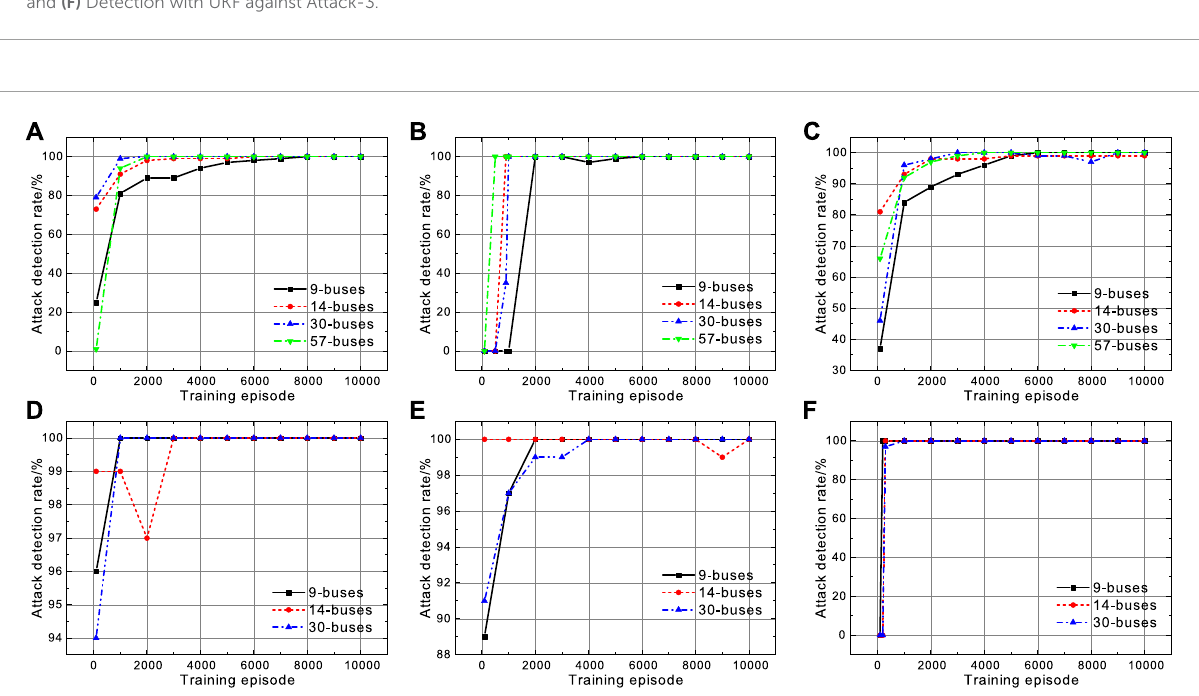
FIGURE 8 Attack detection rate while training against multiple attacks under multiple systems based on EKF or UKF. (A) Training against Attack-1 based on EKF, (B) Training against Attack-2 based on EKF, (C) Training against Attack-3 based on EKF, (D) Training against Attack-1 based on UKF, (E) Training against Attack-2 based on UKF, and (F) Training against Attack-3 based on